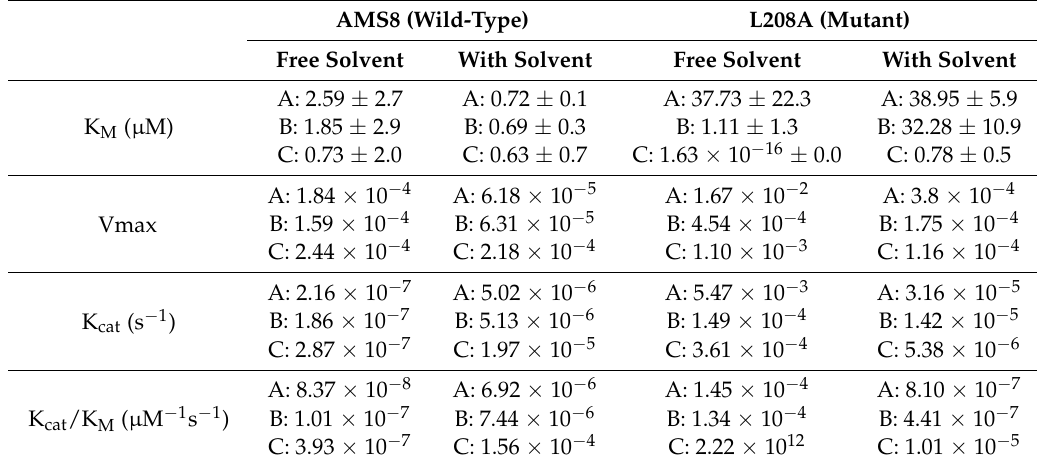
Table 4. Michaelis-Menten kinetics measuring K M and K cat of mutant